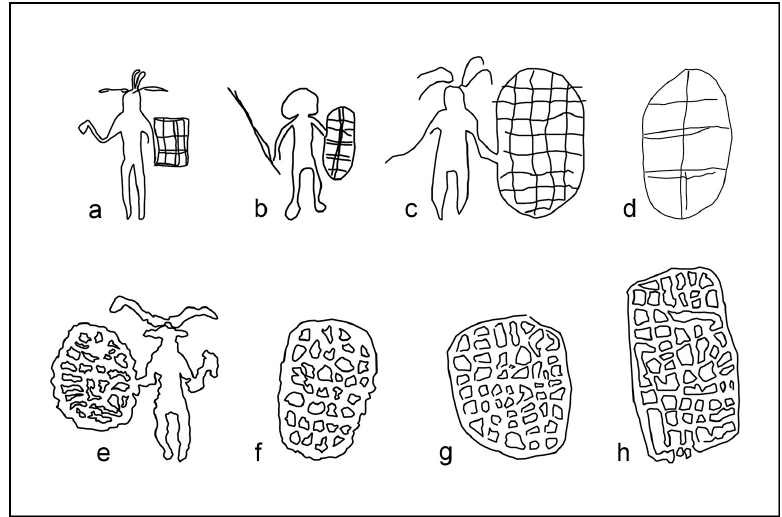
Figure 23. Typological table compiled by redrawing selected petroglyphs published in the scientific literature, all executed by pecking. Petroglyphs from “a” to “d” are from the Anoa ‐ 1 site (redrawn from Choppy et al. (1996), courtesy of Bernard Choppy). Petroglyphs “e” to “f” are petroglyphs documented in a newly reported site in the western sector of the Ennedi (redrawn from a digital picture, courtesy of Stefan Kröpelin). Petroglyphs “g” and “h” are from the Azrenga site, located in the northern sector of the Ennedi (redrawn from Choppy et al. (1996), courtesy of Bernard Choppy). These ones, just two examples over the 61 present in the site, look analogous to the oval objects found in the Anoa area, “e” and “f,” but they are associated by proximity to sketchy animals, not to human depiction thus could represent also traps.